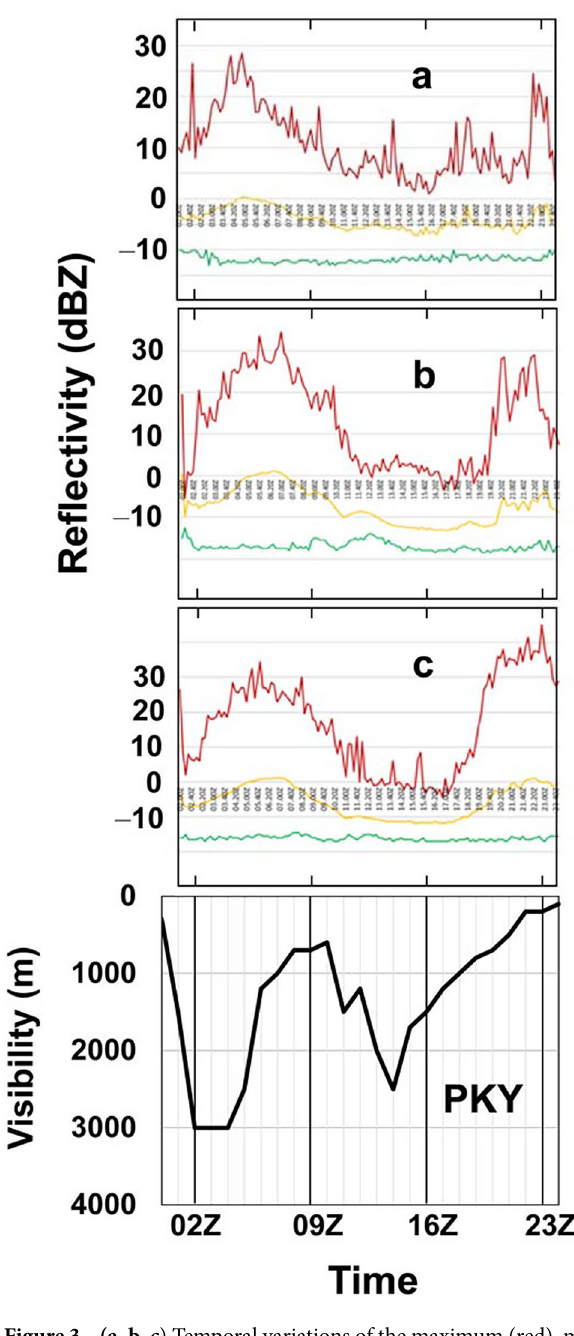
Figure 3. (a, b, c ) Temporal variations of the maximum (red), mean (yellow) and minimum (green) signal intensities of radar echoes in the districts A, B and C of Fig. 1, respectively. PKY : Reversely ordered visibility data at Palangka Raya on 15 October 2015. (EXCEL 2019, Power Point